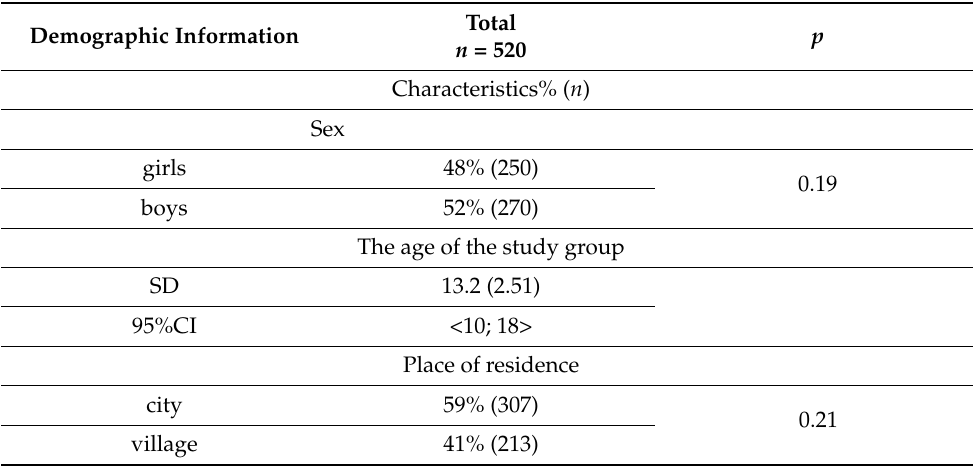
Table 1. Descriptive statistics of the examined group of